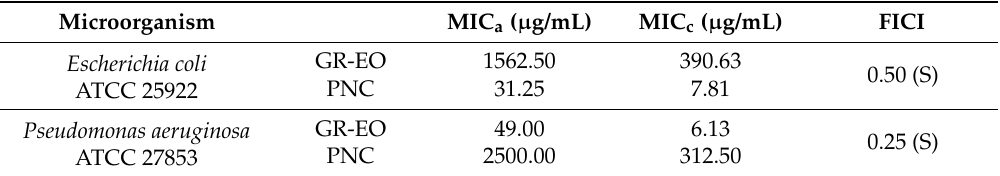
Table 5. Fractional inhibitory concentrations indices (FICIs) of Penicillin combined with GR-EO against tested bacterial strains.